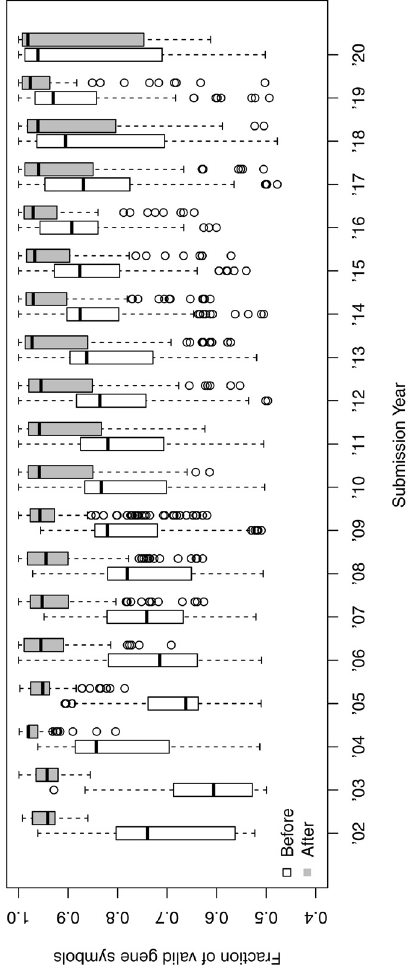
Figure 1. The fraction of valid gene symbols in GPL files grouped by year of data submission. Each dot represents a unique GPL. Older entries show a smaller fraction of valid gene symbols than more recent entries (Before, white box), but many of which are successfully corrected by HGNChelper (After, grey